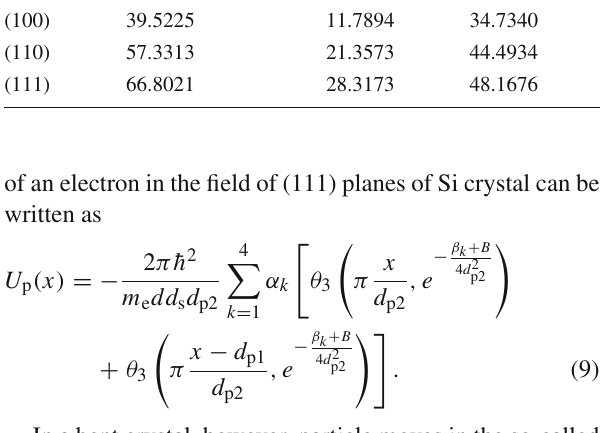
Table 1 Maximum values of the plane potential derivative